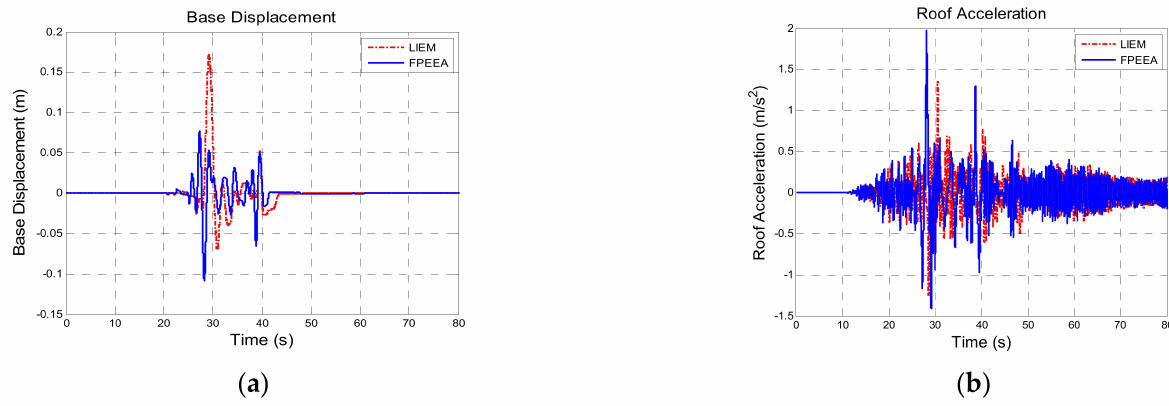
Figure 11. Comparison for the FPEEA and passive controls (TCU102, PGA = 0.1 g). ( a ) Isolation layer displacement. ( b ) Superstructure acceleration.